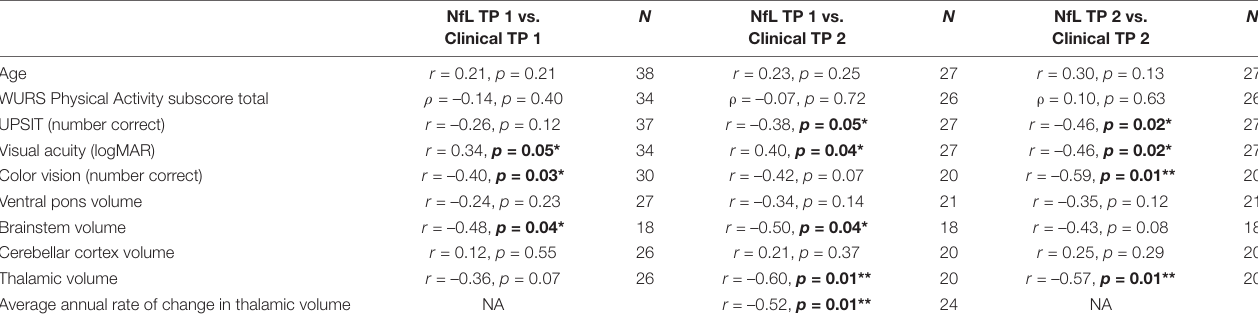
FIGURE 2 | Raw (A) and log10 (B) plasma NfL levels were similar at time points 1 and 2 within individuals in the Wolfram group who had NfL measures at both time points 1.8 years apart on average ( n = 27). NfL, neurofilament light; tp, time point. TABLE 3 | Correlations between log10 plasma neurofilament light levels with age and measures of clinical severity at time points 1 and 2 in individuals with Wolfram